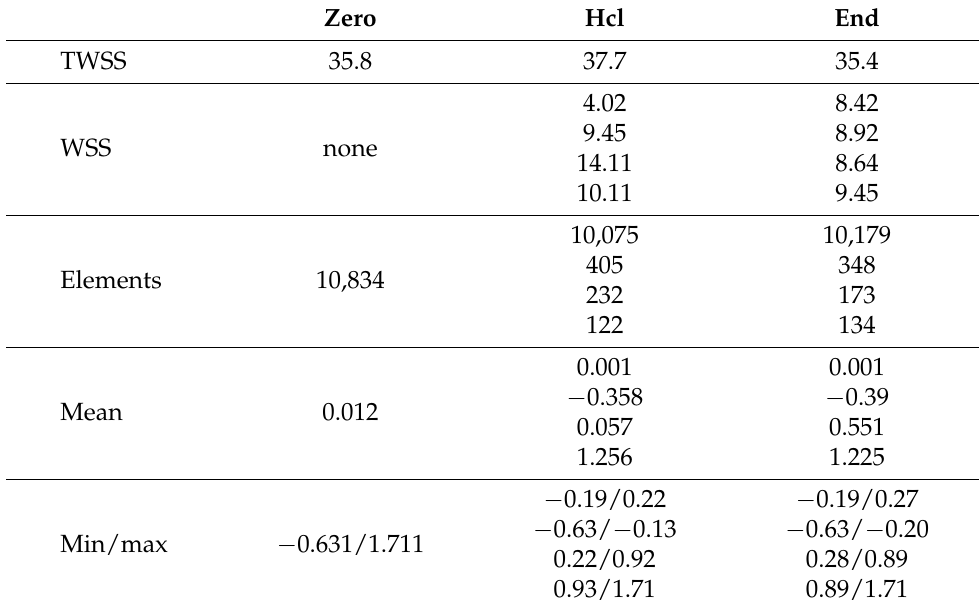
Figure 11. Silhouette of the dataset after K-means algorithm with 4 clusters. Table 3. Step by step comparison of the proposed